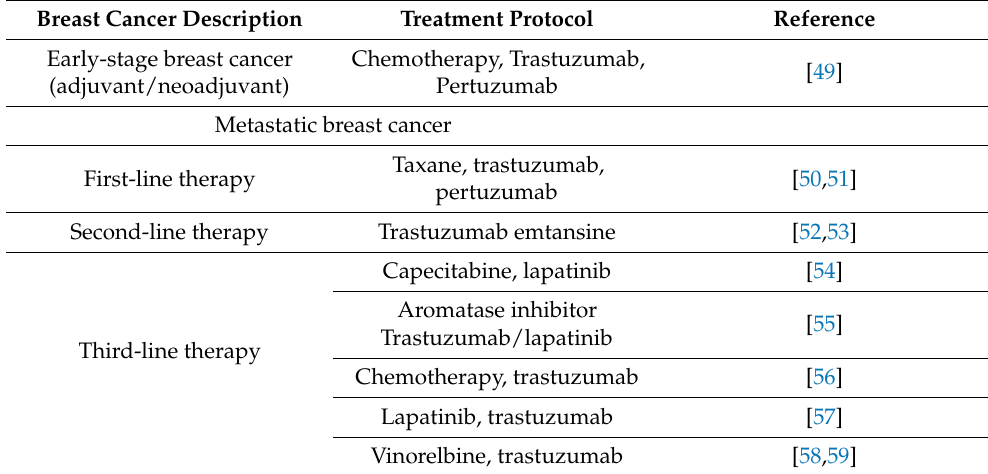
Table 1. Treatment protocols for various stages of HER2-positive breast